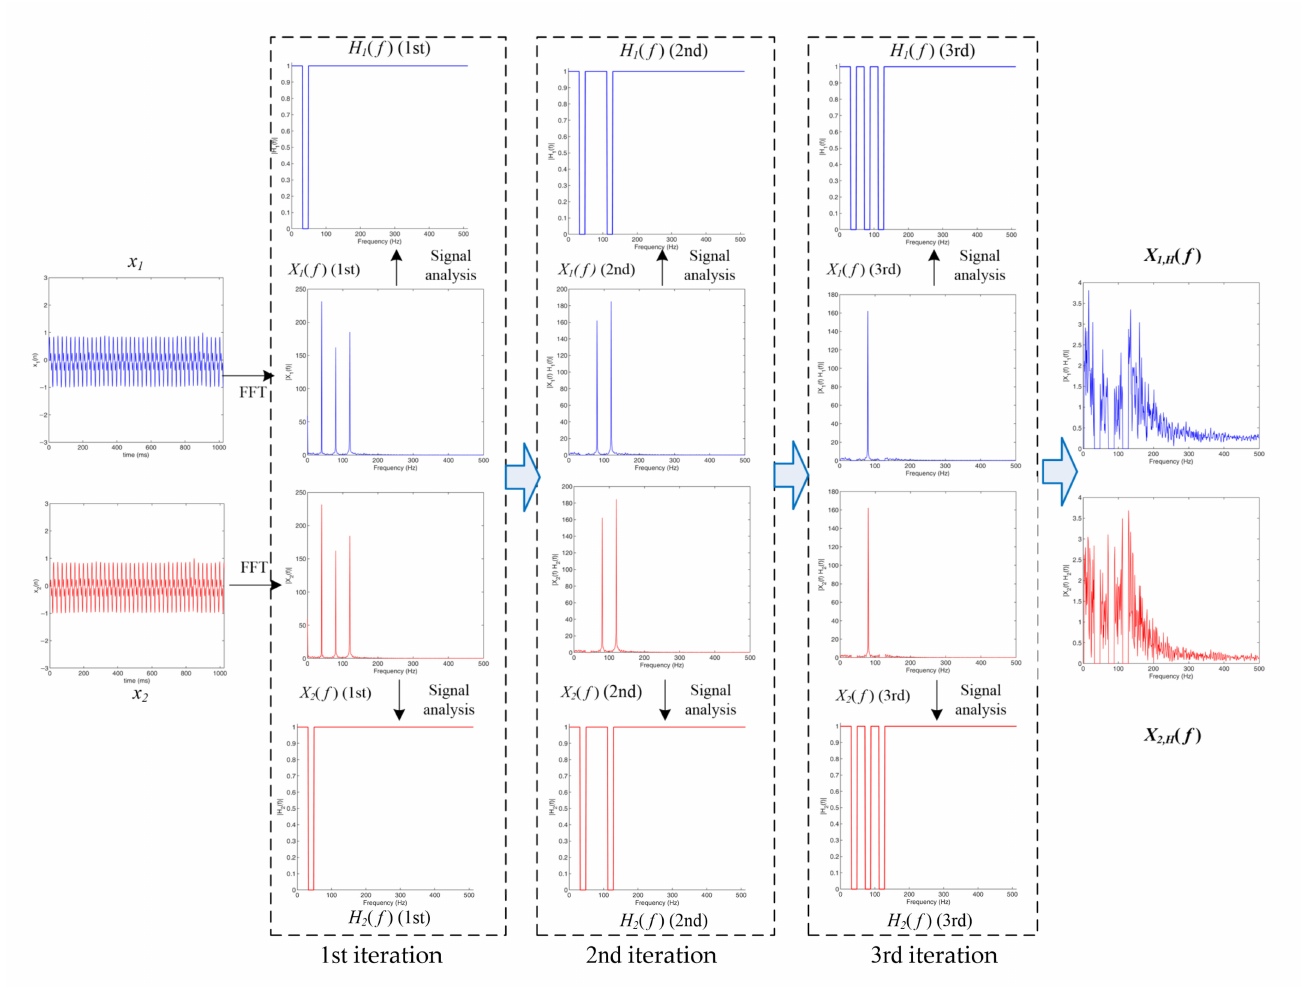
Figure 10. Obtaining the spectra of the filtered signals X 1, H ( f i ) and X 2, H ( f i ) for signals with three strong periodicity